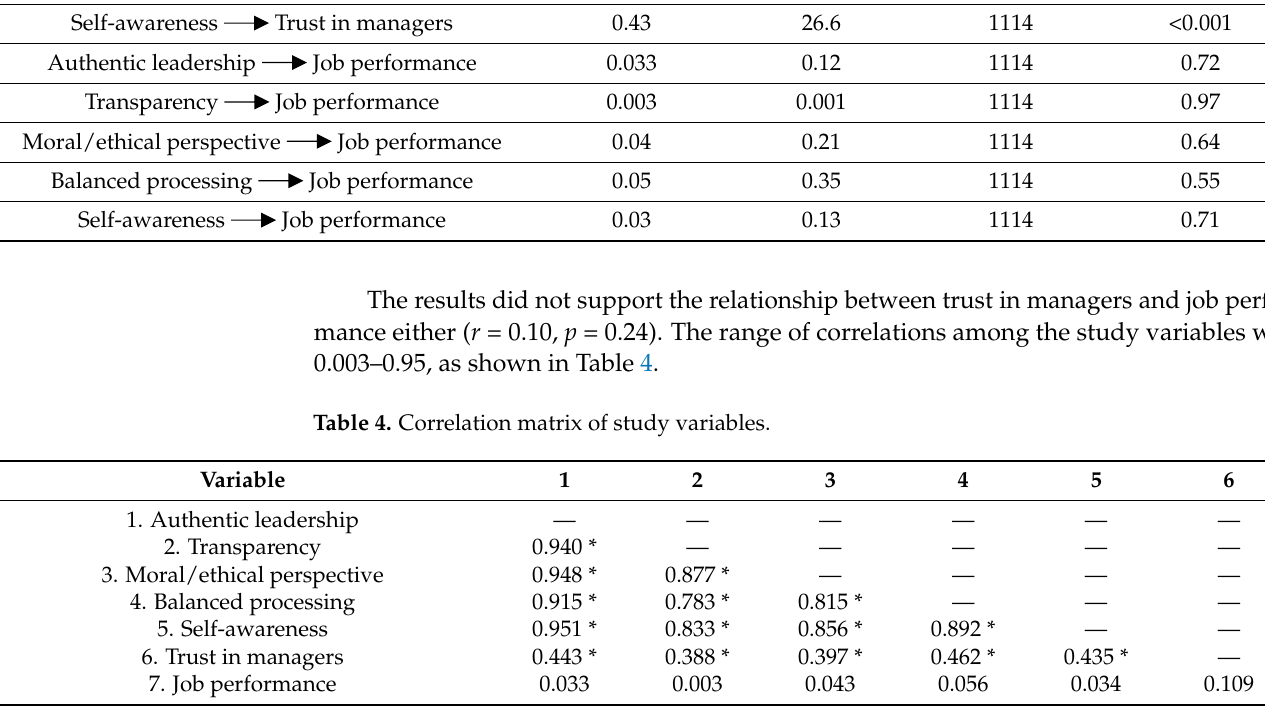
Figure 2. Results of hypothesized model. Table 3. Relationships among study variables.